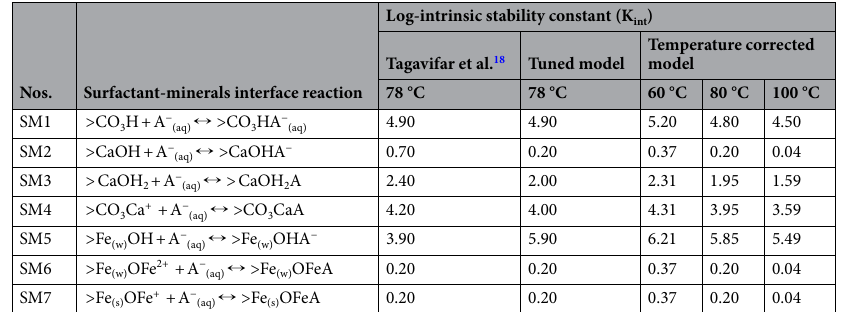
Table 6. Tuned log-intrinsic stability constants for surfactant-minerals interface reactions.